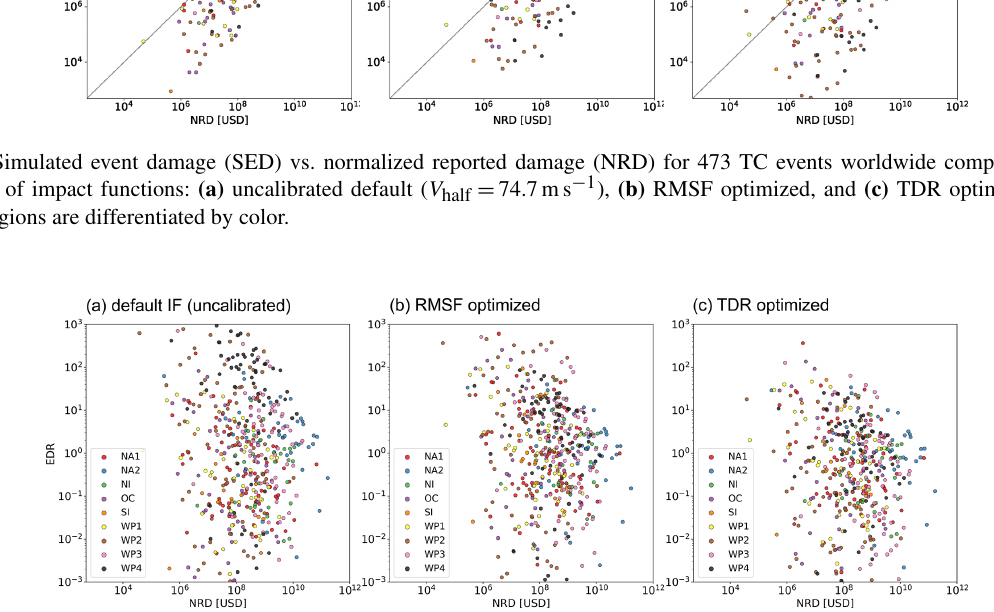
Nat. Hazards Earth Syst. Sci., 21, 393–415,